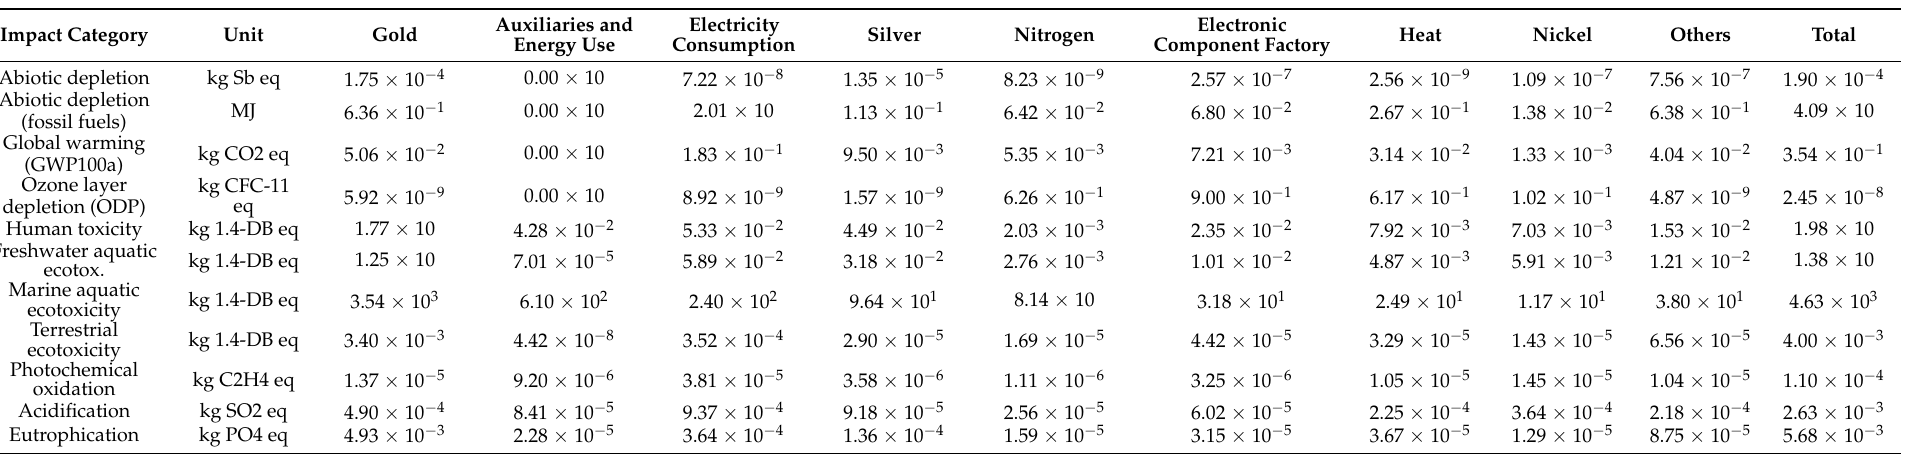
Table 6. Detailed study of environmental impact of diode ESDA14V2L (impacts for 1 g of diode).